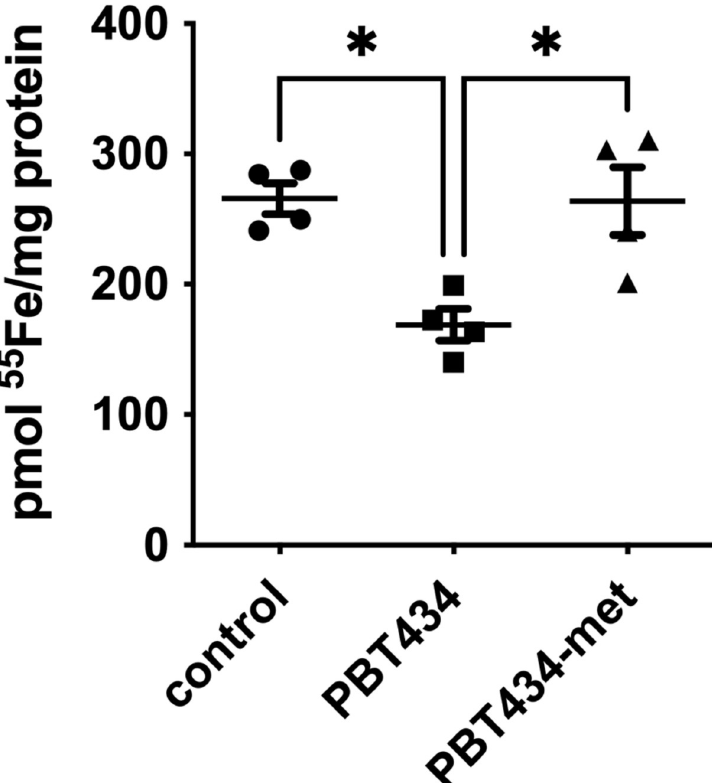
Fig 10. 55 Fe 2+ -transferrin uptake by hBMVEC is inhibited by complexing with PBT434. hBMVEC were loaded with 1 μ M 55 Fe 2+ -Tf at 37˚C for 3h in cells in complex with 20 μ M PBT434 or PBT434-met in the loading media. After 3h, cells were lysed and the amount of 55 Fe 2+ accumulated was calculated. Data are represented as mean ± SEM, n = 4 experimental replicates. Statistical significance was determined using one-way ANOVA and Tukey’s multiple comparison test. � , statistically significantly different from control or as indicated; � , p <